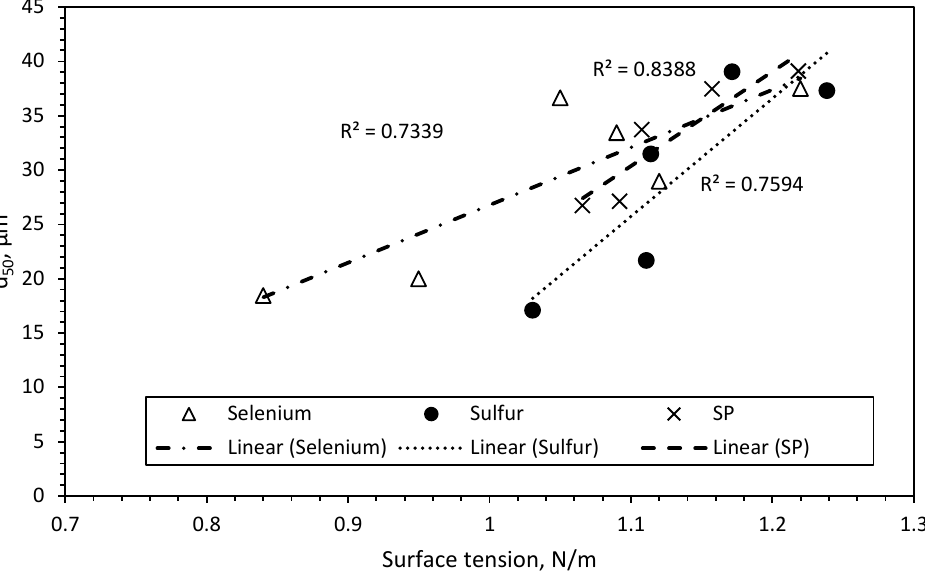
Figure 7. Effect of surface tension on the median powder size d 50 for the steels modified with selenium [17], sulfur [11] and sulfur with phosphorus.